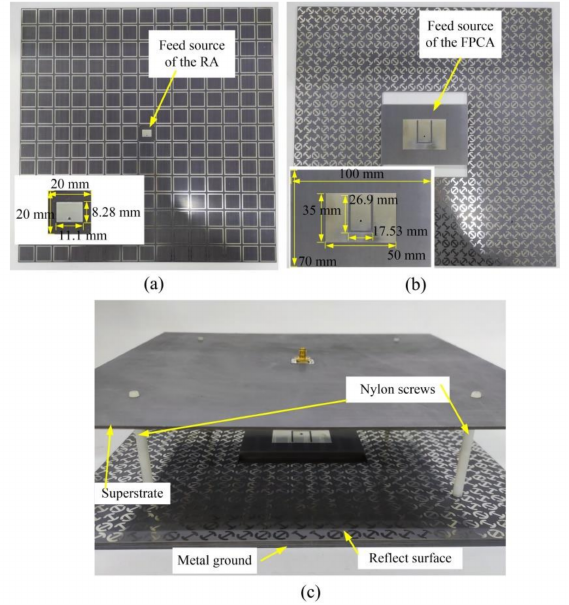
Figure 9. Photographs of ( a ) the fabricated superstrate, ( b ) reflect surface, and ( c ) antenna